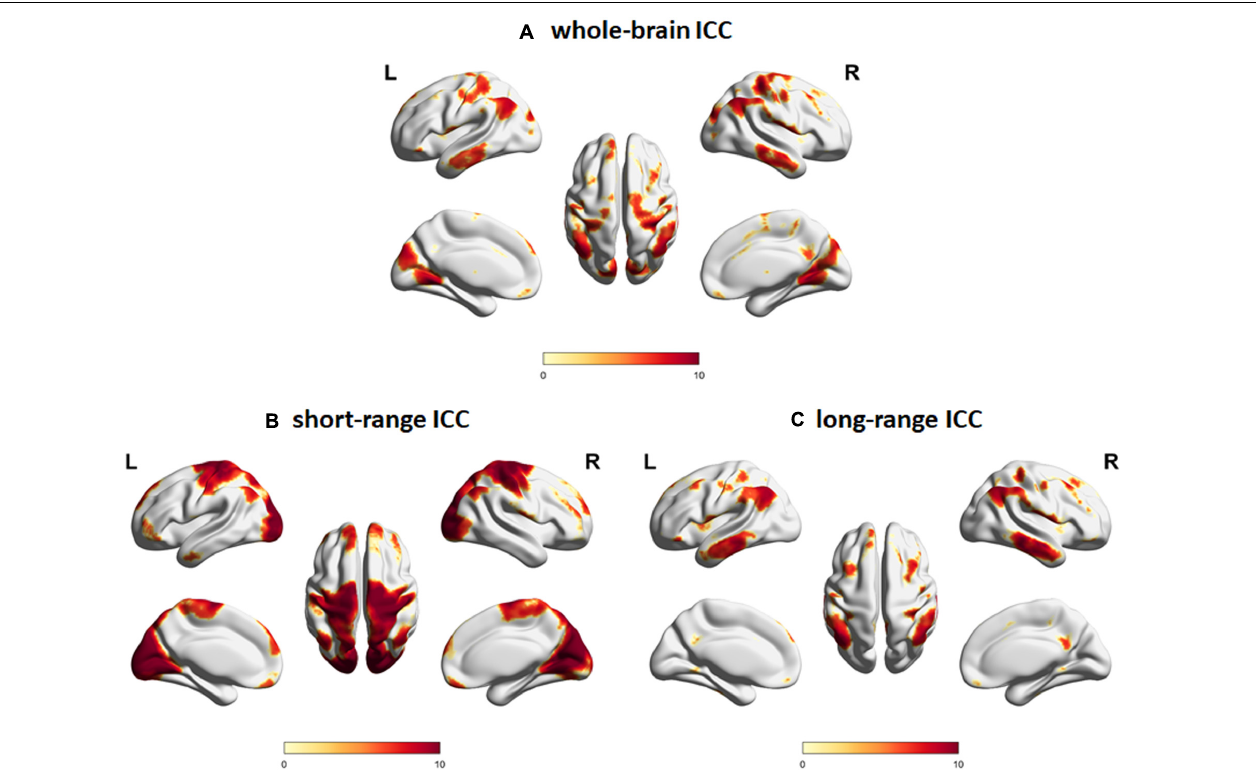
FIGURE 2 | Intrinsic connectivity contrast (ICC) maps for (A) whole-brain connections, (B) short-range connections, and (C) long-range connections constructed using resting state fMRI data from the young adult subgroup (age < 40 years old, N = 60). Regions with significant (FWEc p < 0.05, CDT p = 0.001) ICC values are indicated. Color map encodes t -values mapped on the cortical surface using BrainNet Viewer (Xia et al., 2013). L, left; R, right.